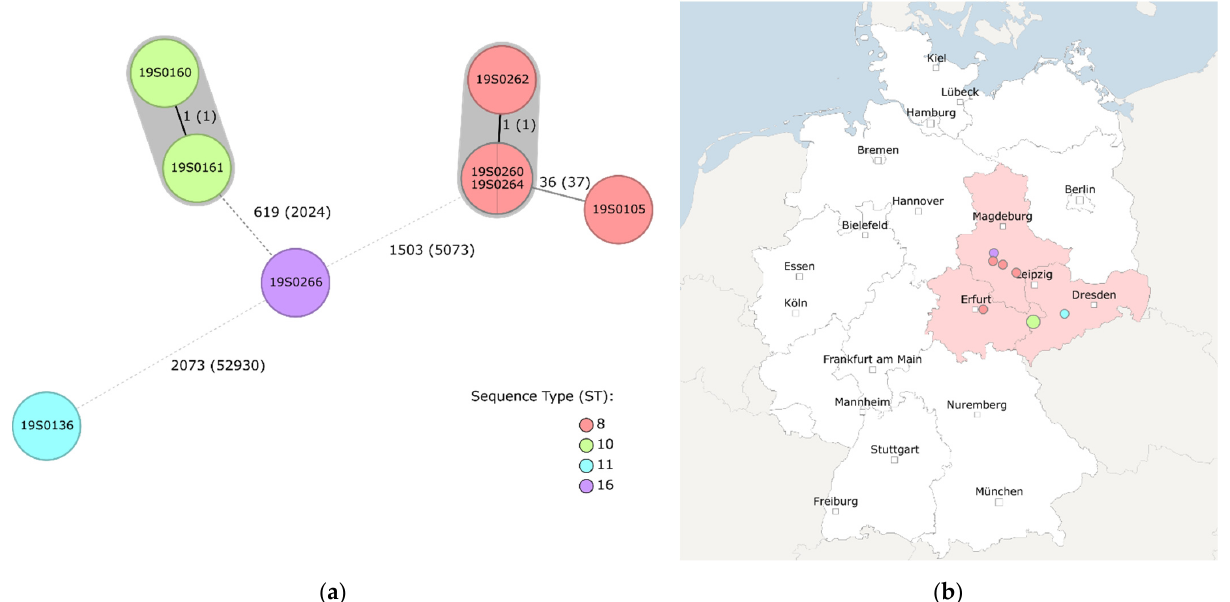
Figure 1. ( a ) Results of core genome multi locus sequence typing (cgMLST) of C. difficile isolates. Numbers next to the branches indicate numbers of allelic differences in the core genome. In brackets, the number of SNPs within the core genome is indicated. cgMLST classified the eight isolates into five genetic groups. Three isolates were singletons, while the other five isolates were grouped into two clusters (marked in grey) with two and three isolates, respectively. Each node represents a cgMLST sequence type (cgST) which was coloured according to their ST (classical MLST) classification. ( b ) Geographic origin (according to postal code) of the corresponding samples to the isolates. 19S0160 and 19S0161 (green; RT 015) originated from the same husbandry. RT 002/2 isolates (19S0260, 19S0162, 19S0264; red) originated from husbandries in Saxony-Anhalt which were close to each other, as did 19S0266 (purple; RT 029). 19S0136 (blue; RT 078) originated from a husbandry in Saxony. Figures were created with Ridom™ SeqSphere+ (v. 8.2.0)